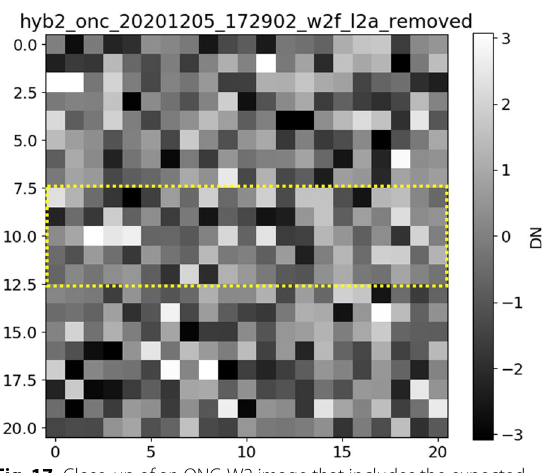
Fig. 17 Close-up of an ONC-W2 image that includes the expected region where the return capsule was observed (indicated by a dotted rectangle), taken at 17:29:02 p.m. on December 5, 2022 Fig. 18 Relationship between the apparent brightness temperature and the DNs of ONC-W2, observed from a 350 km